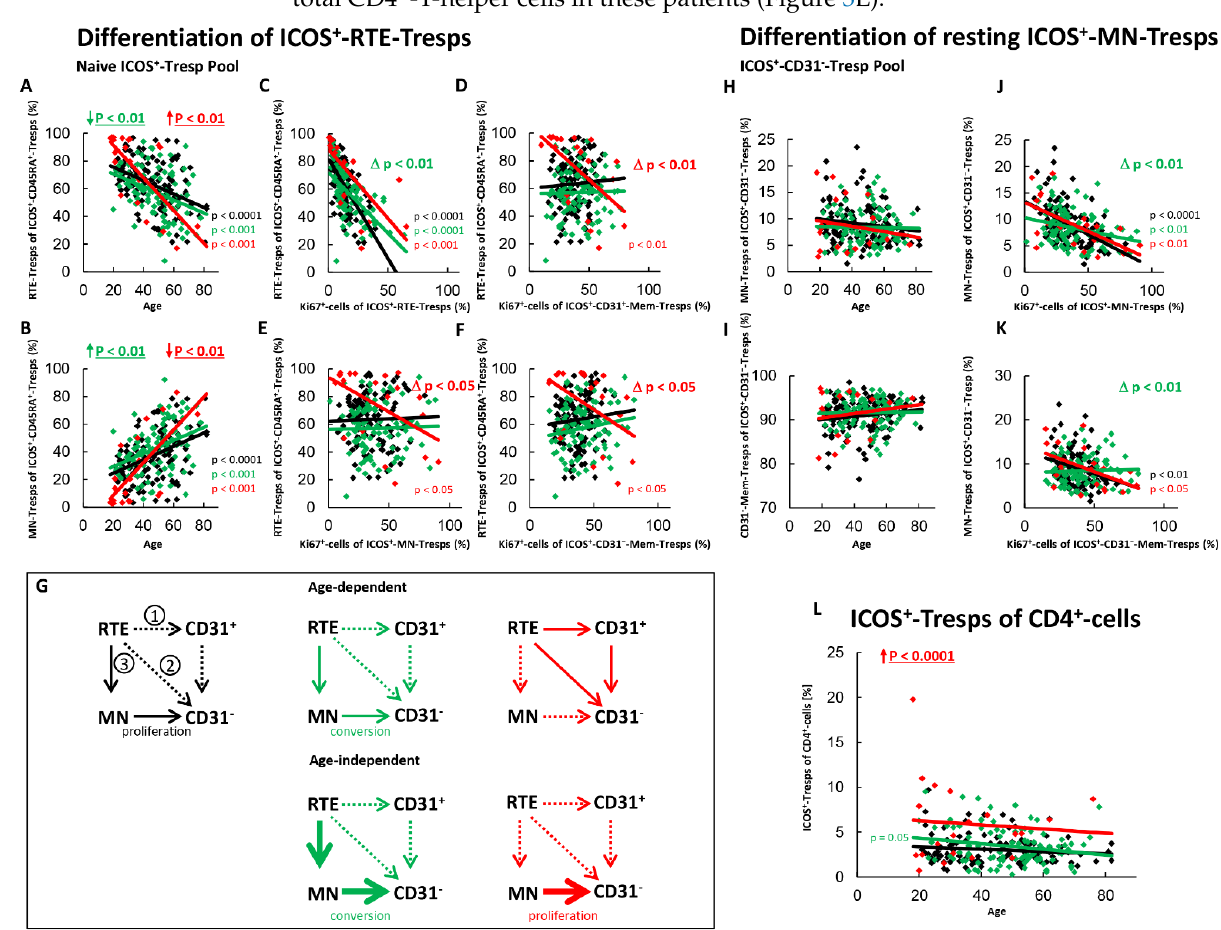
Figure 3. Differentiation of ICOS + -RTE-Tresps and resting ICOS + -MN-Tresps with age in healthy controls, SLE patients in remission and SLE patients with active disease. The percentages of RTE-Tresps and MN-Tresps within the naïve ICOS + - CD45RA + -Tresp pool ( A , B ) as well as the percentages of MN-Tresps and CD31 − -memory Tresps within the ICOS + -CD31 − - Tresp pool ( H , I ) were estimated depending on age, in healthy volunteers (Black coloured), SLE patients in remission (Green coloured) and SLE patients with active disease (Red coloured). In order to examine the differentiation of ICOS + -RTE-Tresps, the percentage of RTE-Tresps within total naïve CD45RA + -Tresps was correlated with the percentage of Ki67 + cells within total RTE-Tresps ( C ), CD31 + -memory-Tresps ( D ), MN-Tresps ( E ) and CD31 − -memory-Tresps ( F ). In order to examine the differentiation of resting MN-Tresp, the percentage of MN-Tresps within total CD31 − -Tresps was correlated with the percentage of Ki67 + cells within total MN-Tresps ( J ) and within total CD31 − -memory-Tresps ( K ). Significant linear regression analyses are marked by black, green, or red P-values. Significant differences in the regression lines between healthy controls and SLE patients in remission or active disease are marked by green or red ∆ p values. Age-independent significant differences between healthy volunteers and study groups are marked by an arrow ( ↑↓ ) and their color-matched P-values. The arrow diagrams ( G ) schematize an increased (thick arrow), consistent (thin arrow) or decreased (dashed arrow) differentiation, color matched for the different patient groups. The resulting age-dependent and age-independent changes in the percentage of ICOS + -Tresps within total CD4 + -T-helper cells are given in ( L ). Further information of the calculated P-values is illustrated in Table